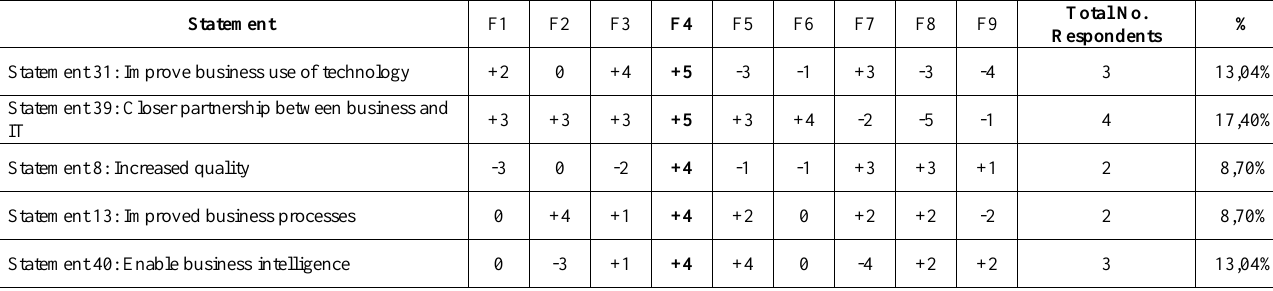
Table 8: Factor 4. Technology leverager, key items